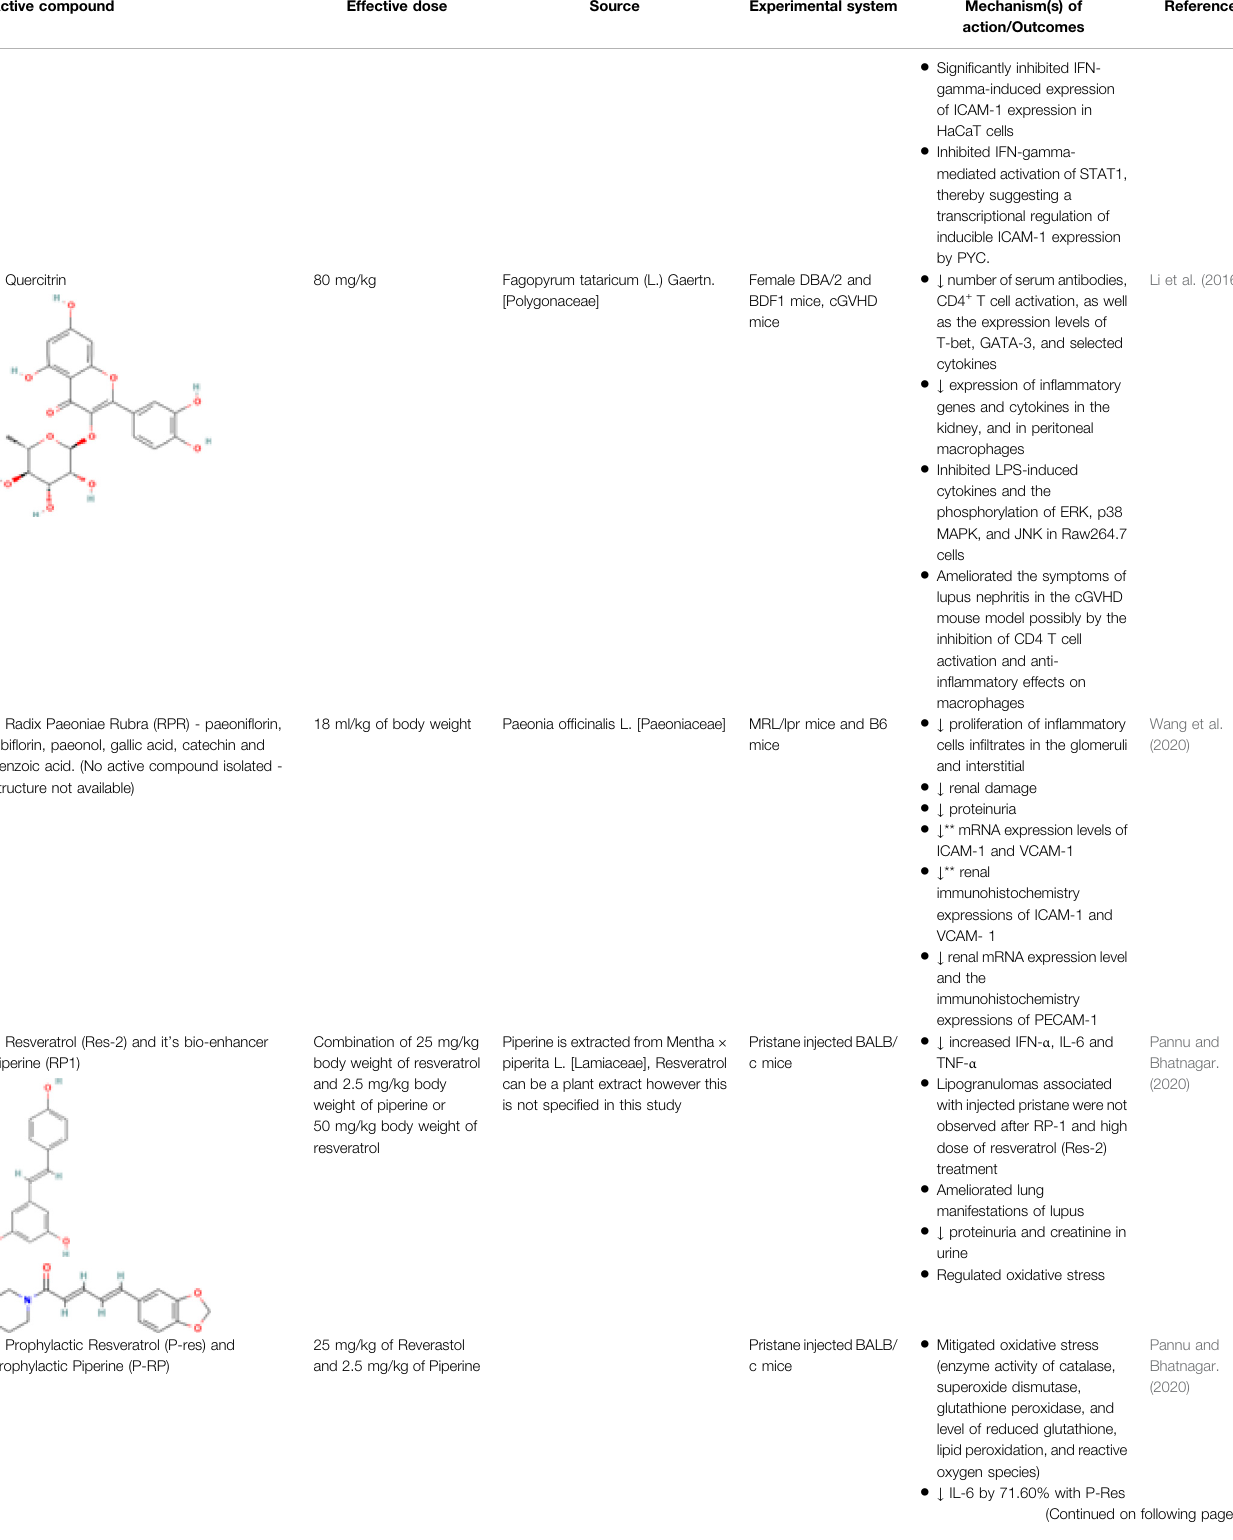
TABLE 1 | ( Continued ) Synthesized fi ndings for potential bioactive compounds for